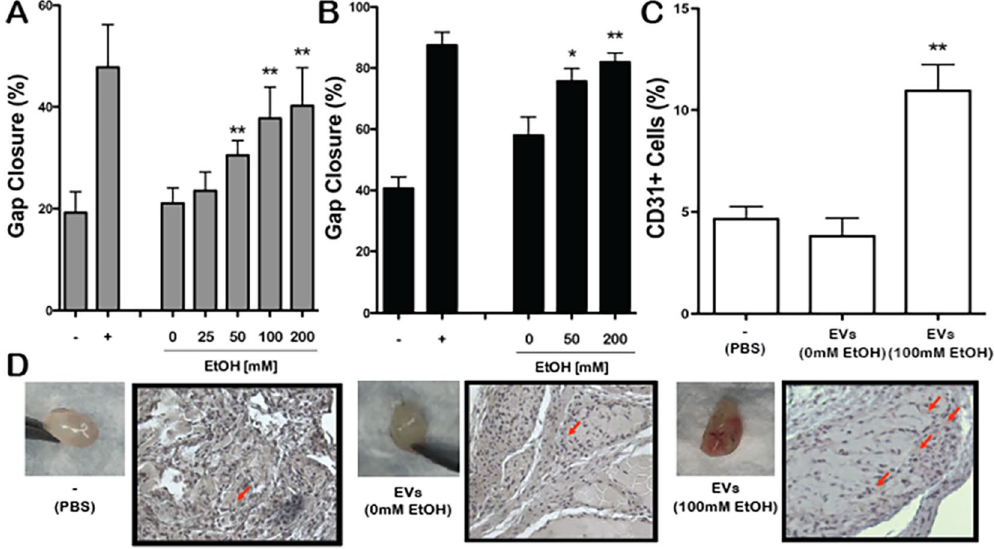
Figure 2. Ethanol conditioning increases endothelial cell-derived EV vascularization bioactivity. Gap closure by ( A ) HUVECs and ( B ) HDMECs was assessed following stimulation by 100 µ g/ml EVs isolated from the same producer cell type in medium with the indicated ethanol (EtOH) concentrations (n = 3, * P < 0.05, ** P < 0.01 vs. 0 mM EtOH condition); HUVECs incubated in basal medium (EBM2, without growth factors) were used as the negative control ( − ) and HUVECs incubated in growth medium (EGM2, with growth factors) were used as positive controls ( + ). ( C ) Matrigel plugs injected into C57Bl/6 mice containing PBS as a negative control ( − ) or 100 µ g HUVEC EVs from cells cultured with the indicated concentrations of EtOH in the media were removed 10 d after implantation and CD31 + cells were quantified using immunohistochemical staining (n = 6; ** P < 0.01 compared to all other groups by one-way ANOVA). Data are presented as %CD31 + stained cells out of all cells counted for the gel sections from a given animal. ( D ) Representative gel images and immunohistochemistry sections from animals in the indicated groups are shown (n = 6).